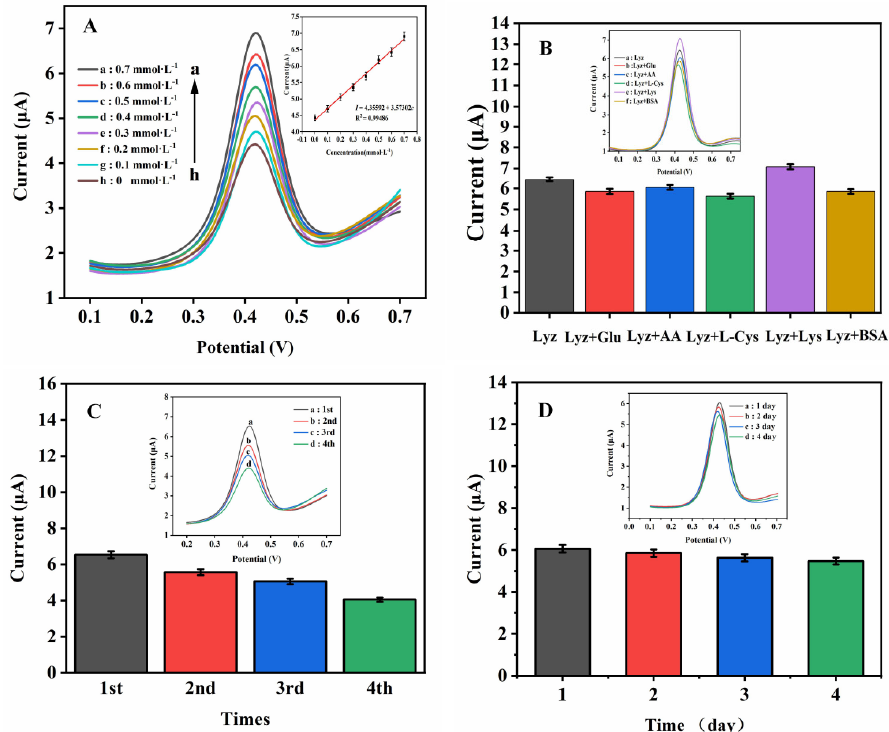
Figure 3. ( A ) DPVs of Lyz at different concentrations (h–a: 0, 0.1, 0.2, 0.3, 0.4, 0.5, 0.6, and 0.7 mmol ∙ L − 1 , respectively) under optimal conditions, insert: calibration plot in various concentrations of Lyz at Fc(COOH) 2 /AuNPs/GCE. The study of selectivity ( B ), repeatability ( C ), and stability ( D ) of the Fc(COOH) 2 /AuNPs/GCE for Lyz detection under optimal conditions. Figures 3B–D display selectivity, repeatability, and stability of Fc(COOH) 2 /AuNPs/GCE sensors. The selectivity of Fc(COOH) 2 /AuNPs/GCE sensor was sponses in Lyz (0.5 mmol ∙ L − 1 ) and the mixture of Lyz, and interferences in a 10:1 mixing ratio (Lyz, Lyz + Glu, Lyz + AA, Lyz + L ‐ Cys, Lyz + Lys, and Lyz + BSA), a slight change in the current on the sensor was observed in different solutions with a total R.S.D. of 8.65%. The results verify an excellent selectivity of the sensor. To explore the repeatability of the sensor, a Fc(COOH) 2 /AuNPs/GCE sensor (after each measurement, the electrode was cleaned by Milli ‐ Q water) was continuously tested four times by DPV in 0.5 mmol ∙ L − 1 Lyz solution. The peak current gradually decreases from first (6.53 μ A) to fourth (4.05 μ A), as shown in Figure 3C. This may be a result from the increase in the electrochemical reaction products at the interface and the decrease in electrodes surface ‐ modifying species at the same time. For stability investigation, four Fc(COOH) 2 /AuNPs/GCE sensors were fabricated to detect 0.5 mmol ∙ L − 1 Lyz on different days. Figure 3D showed the sensor was stable within four days, which indicates Fc(COOH) 2 /AuNPs/GCE sensor has good stabil ‐ ity. 3.5. Foods Sample Analysis In the sample detection experiment, the egg white was diluted 10 times with triso ‐ dium citrate solution and stored in the refrigerator at 4 °C. The appropriate volume of the solution was tested three times using the standard addition method, and the results are shown in Table 1. It indicates the sensor had potential applications in detecting Lyz, the calculated value of Lyz concentration in undiluted blank egg white is 190 μ mol ∙ L − 1 , which is close to the value (50 μ mol ∙ L − 1 ) reported in the literature [48], the average recovery of